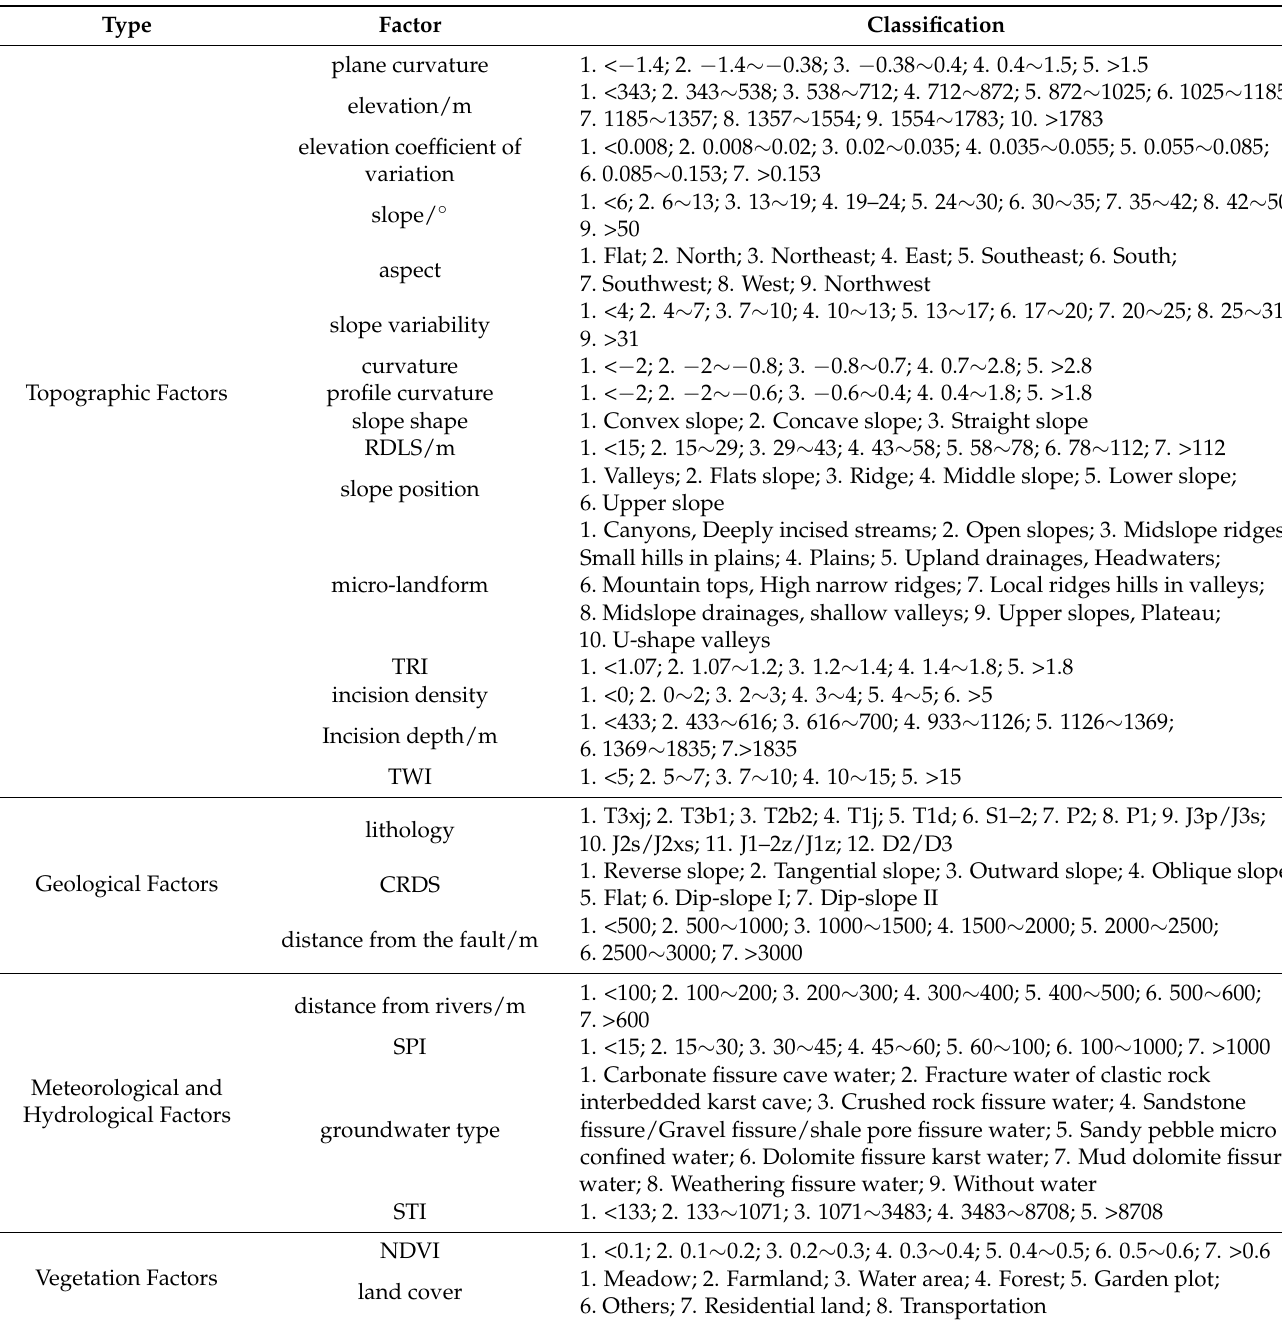
Table 2. Classification of conditioning factors of landslide